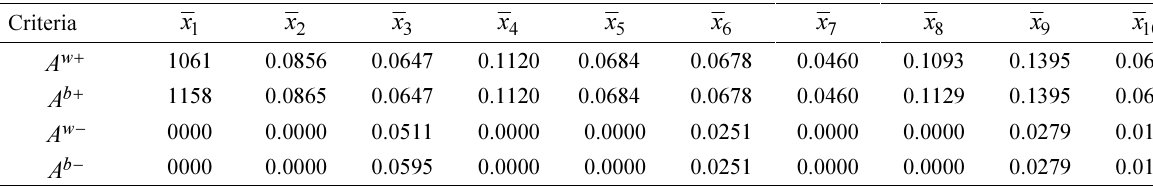
Table 5. Ideal and negative-ideal solutions Criteria